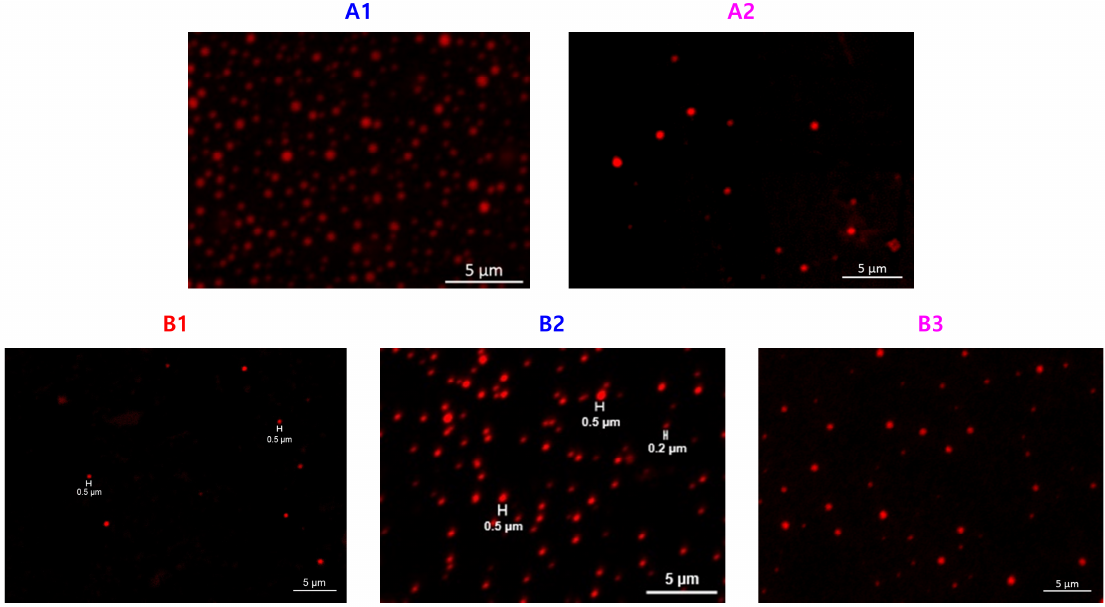
Figure 9. Confocal images of PEG-b-PDVBP submicron particles.